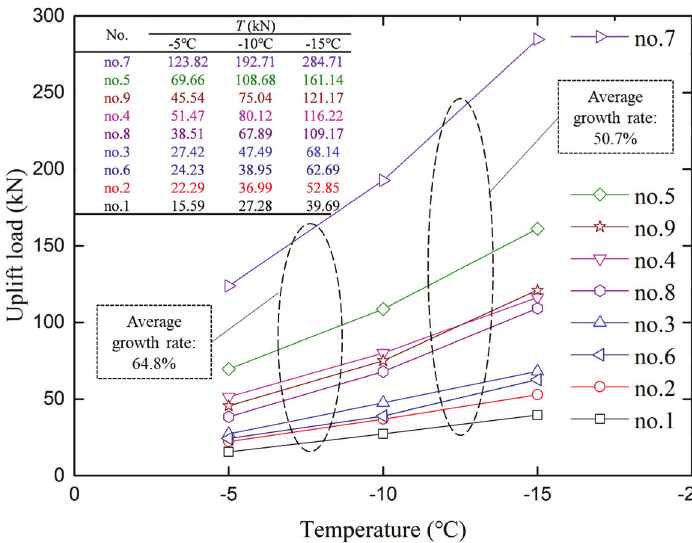
Figure 15. Ultimate uplift load of foundations of nine sizes at three freezing temperatures.